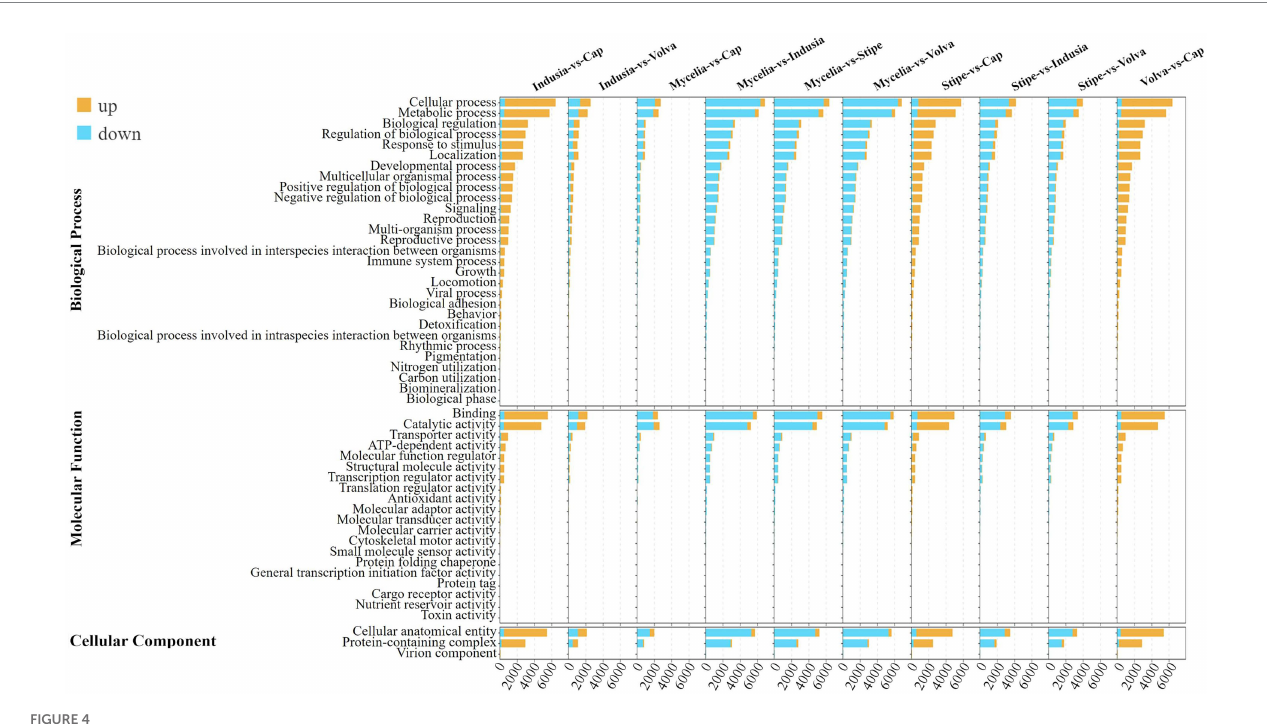
FIGURE 4 GO enrichment of the differentially expressed genes of different comparison groups. Different colors indicate the number of upregulated and downregulated genes in multiple comparison groups. In the upper left corner is the figure legend.